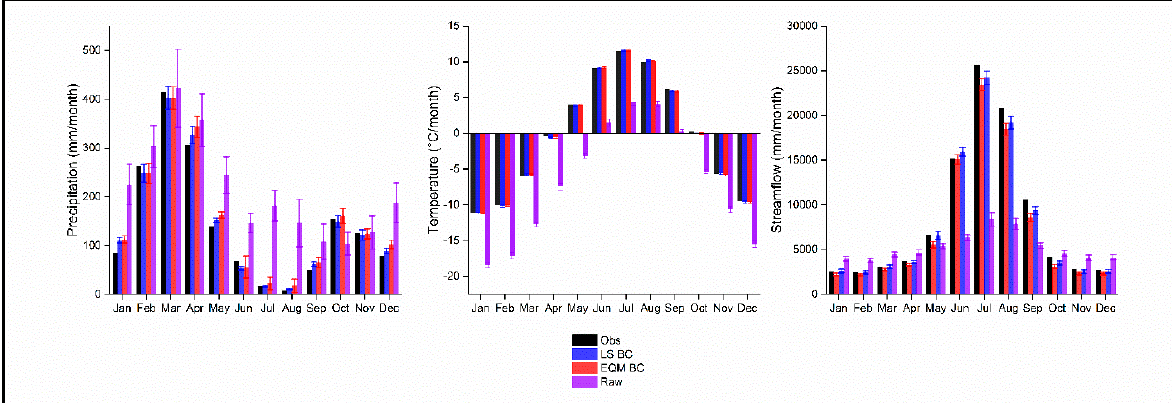
Figure 3. Left: mean monthly precipitation (left), temperature (center), and streamflow (right), as provided by observed station data (Obs) and the ensemble mean of the 21 NEX-GDDP models when they were LS-corrected (LS BC), EQM-corrected (EQM BC), and their raw outputs (Raw) were considered for the reference period (1995–2005). The error bars represent the standard deviation across the 21 models.